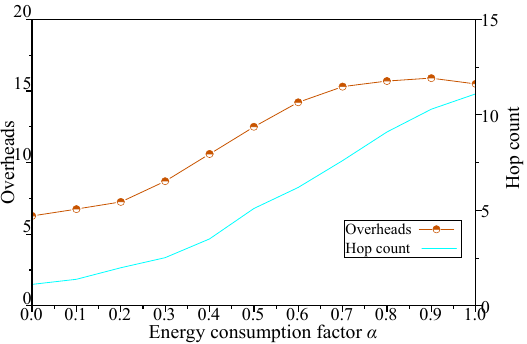
Figure 12. Influence of α on network overhead and hop count.